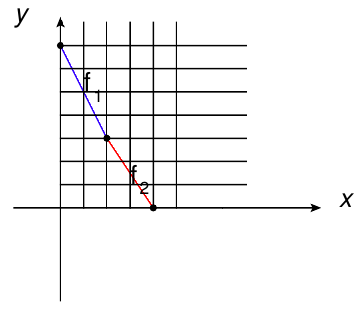
Figure 17 . Newton polyhedron for singularity f = x 4 + y 7 + x 2 y 3